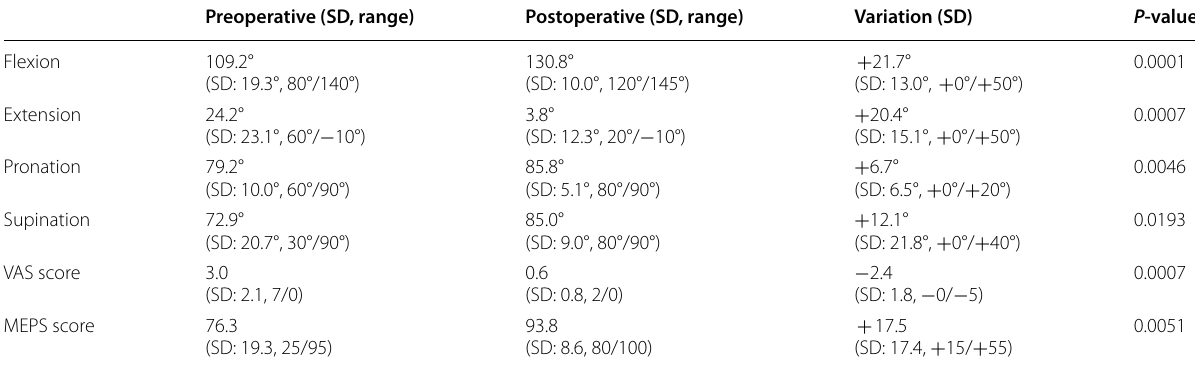
Overall clinical results of the PTS group patients. For each measured outcome (flexion, extension, pronation, supination, VAS score, and MEPS score) the preoperative and postoperative means (with SD standard deviation and range with minimum / maximum value obtained), the variation, and the P -value are reported